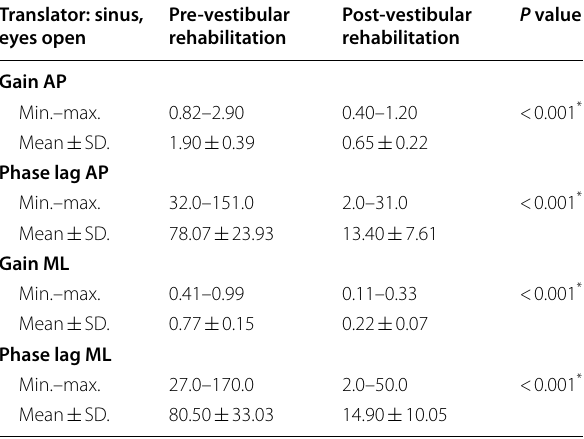
Table 12 Translator: RAMP, eyes open scores in pre- and post-